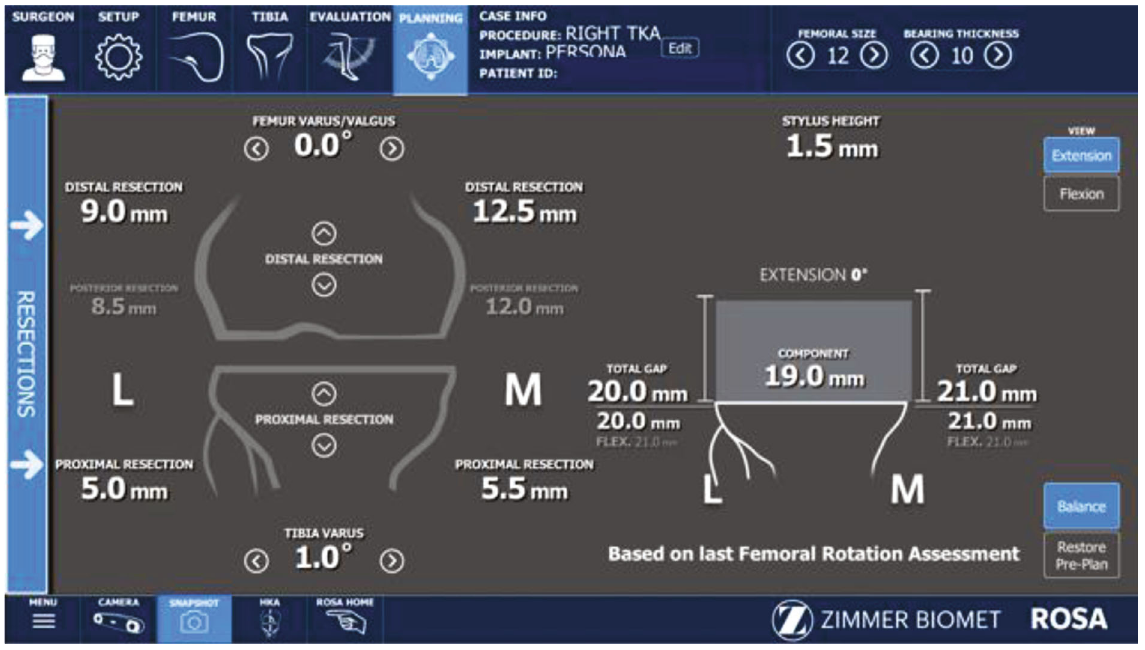
Figure 13: The generated resection plan for Case 4.